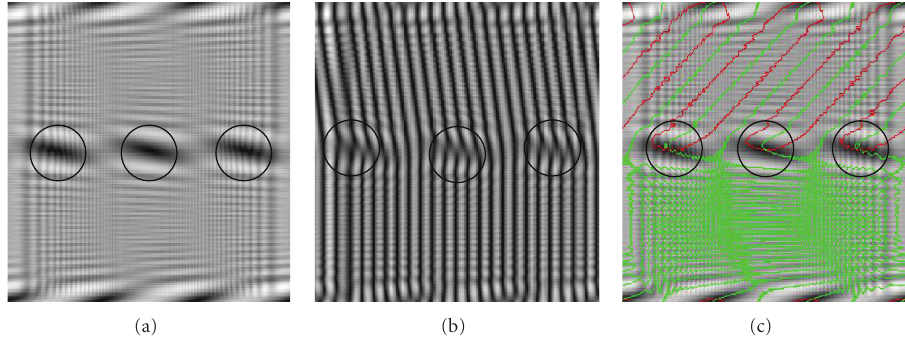
Figure 8: (a) Simulated intensity distribution for linear array of inclined phase ramps with constant background. (b) Simulated interference patterns to check formation of optical vortices. (c) Simulated results for zero crossing of real and imaginary lines for linear array of inclined phase ramps with constant background. Green line represents real part and red line represents imaginary part of the wave